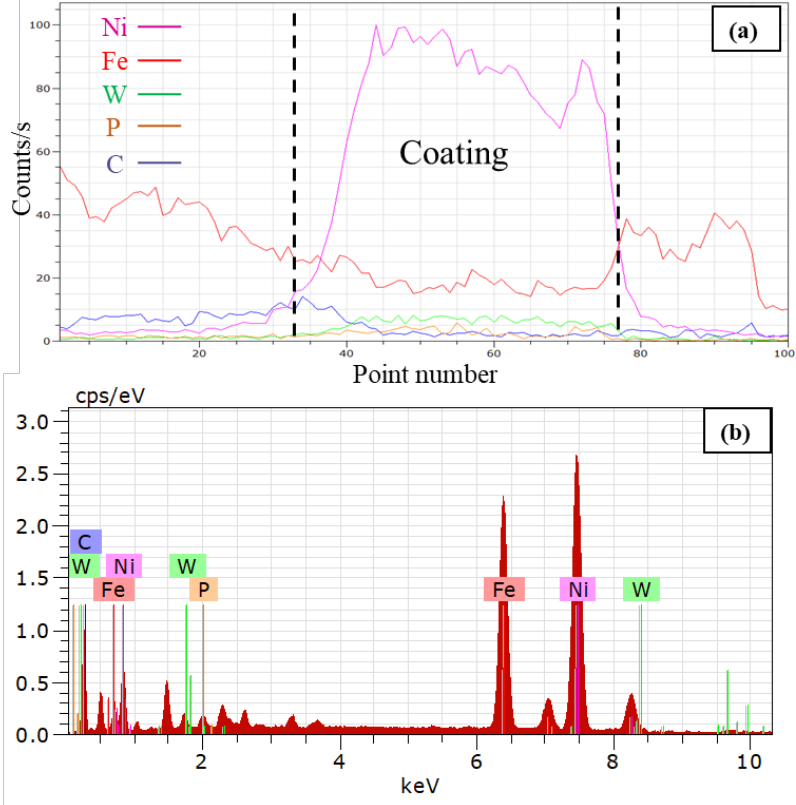
Figure 6. ( a , b ) Energy dispersive spectroscopy results of Figure 5e.